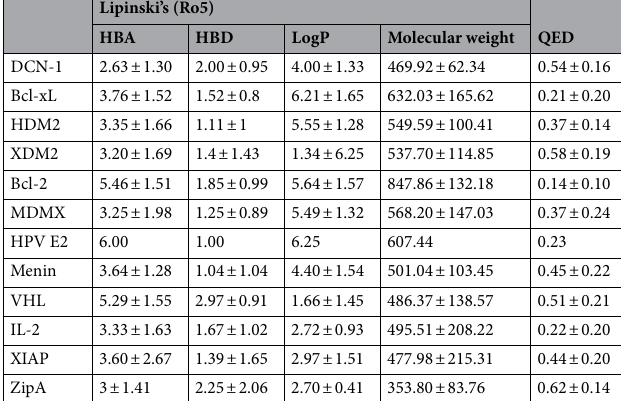
Table 5. Calculated physiochemical properties of published inhibitors based on Lipinski’s rule of 5 (Ro5) and QED scores. Data represents mean ± standard